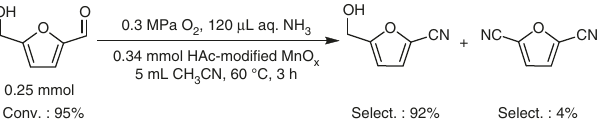
Fig. 6 Chemoselective ammoxidation of 5-hydroxymethylfurfural. The HAc- modi fi ed MnO x catalyst is effective for the selective ammoxidation of 5- hydroxymethylfurfural to hydroxynitrile